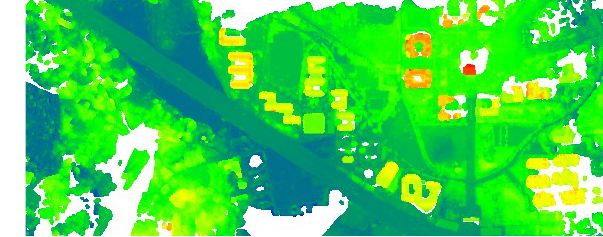
Figure 4 Pseudo-color elevation digital elevation model (DEM)